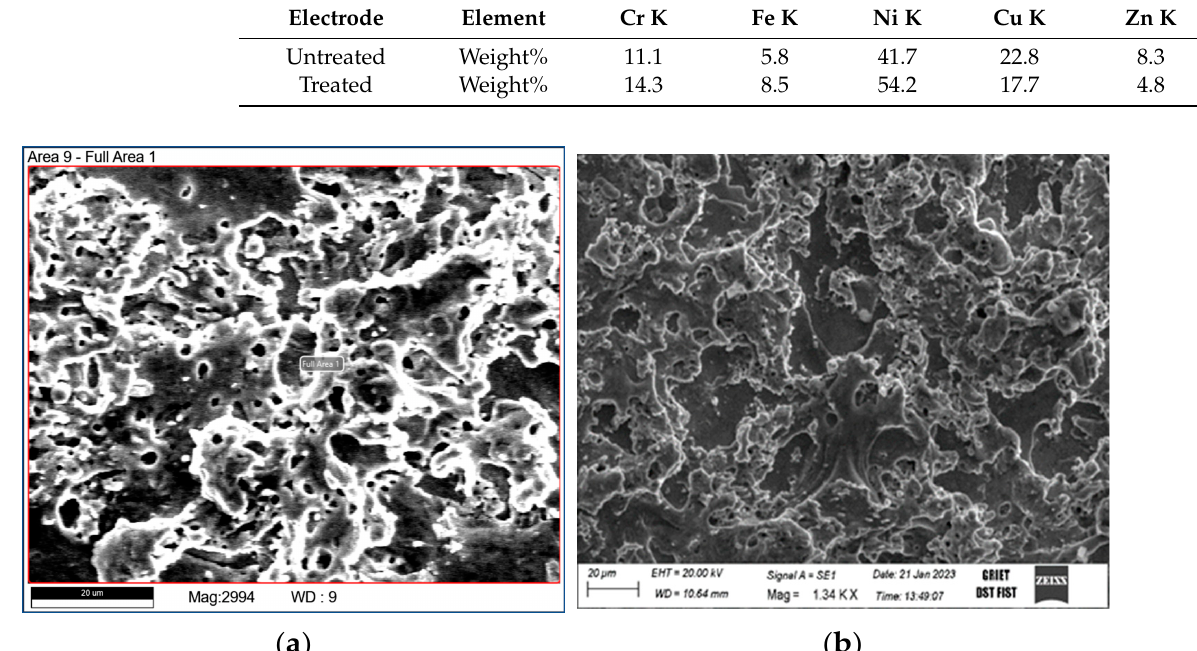
Figure 3. Micrographs of the machined surfaces of the ( a ) untreated and ( b ) cryogenically treated elec-